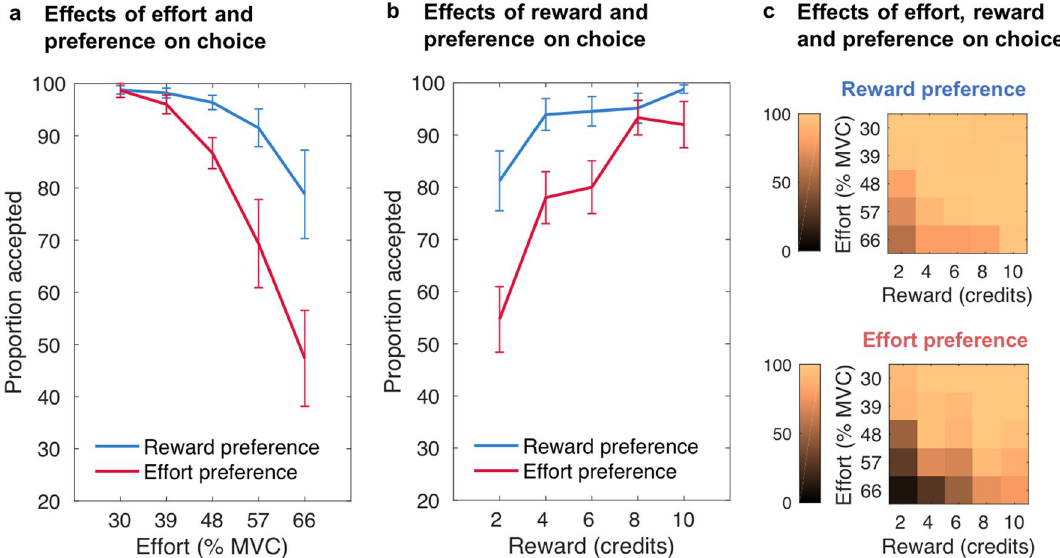
Figure 4. The willingness to exert effort for reward varies with general preferences for seeking effort or reward information first. Mean proportion of accepted work offers as a function of general preference (proportion of trials choosing effort or reward first), dependent on ( a ) the effort level, ( b ) the reward level, and ( c ) the effort and reward levels of the work offer. Although statistical analyses used a continuous variable, for illustration purposes here reward preference reflects the participants who chose to first see reward information in at least 80% of all trials, while effort preference depicts choice behaviour from participants who chose to first see effort information in at least 80% of trials. There was an interaction between people’s information seeking preference and willingness to exert effort, with people favouring seeking effort information first less willing to exert higher levels of effort for rewards than people favouring seeing reward information first. Error bars represent standard errors of the